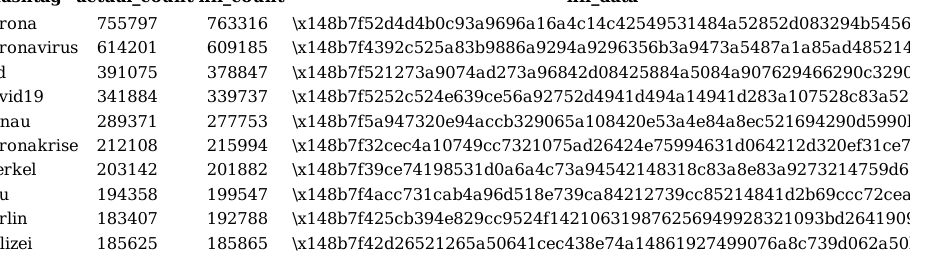
Figure 2. Most frequent descriptive metadata terms (hashtags) of posts in the sample dataset for the focus group discussion are shown in column one. The next two columns show the number of posts that contain these hashtags. Column two shows the corresponding raw count, the actual number of posts in the dataset. The equivalent HLL count, the value estimated by the HLL algorithm, is shown in column tree. The last column shows the HLL-processed data structure and emphasizes the impossibility to read original data from